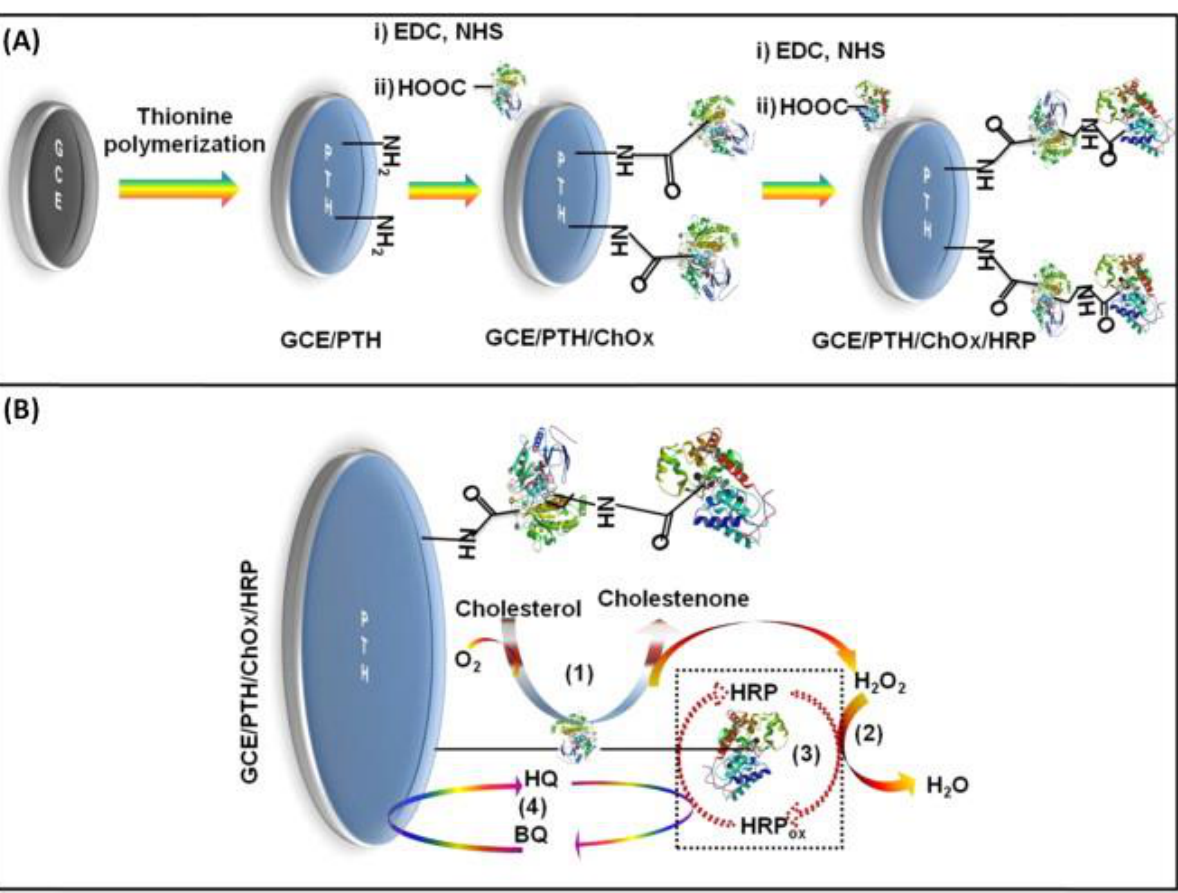
Figure 7. Schematic representation for the fabrication of GCE/PTH/ChOx/HRP biosensor ( A ) and the reaction processes at the GCE/PTH/ChOx/HRP biosensor ( B ). The crystal structures of cholesterol oxidase (ChOx) and horseradish peroxidase (HRP) enzyme was obtained from Protein Data Bank (ID: 2IOK.pdb and IHCH.pdb, respectively) [53]. Reprinted with permission from ref. [53]. Copyright 2014 Elsevier.